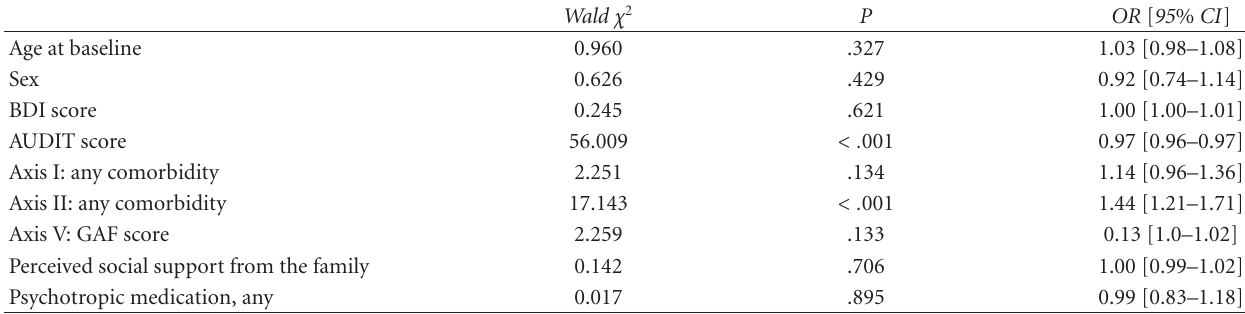
Table 4: Logistic regression analysis of treatment attendance 1 during one-year followup on baseline clinical and treatment-related